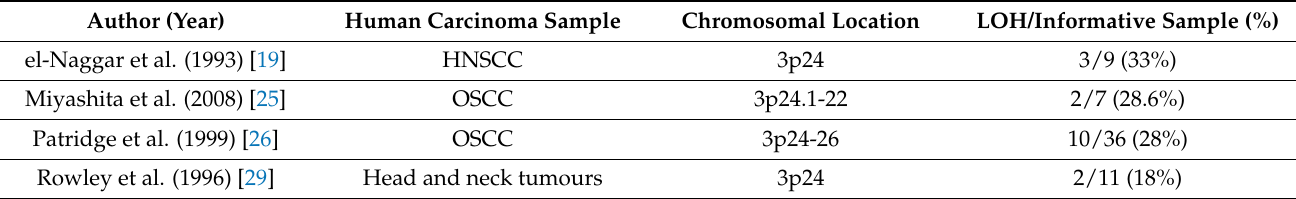
Table 2. LOH in THRB gene